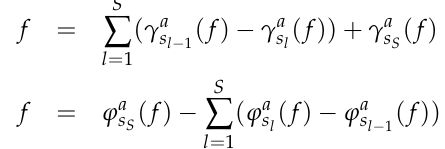
Figure 1. Illustration of an area opening g a s We can see that the connected components removed by the opening operator are the white circles since their area is 5, so below 7, and similarly for the black circles in the closed